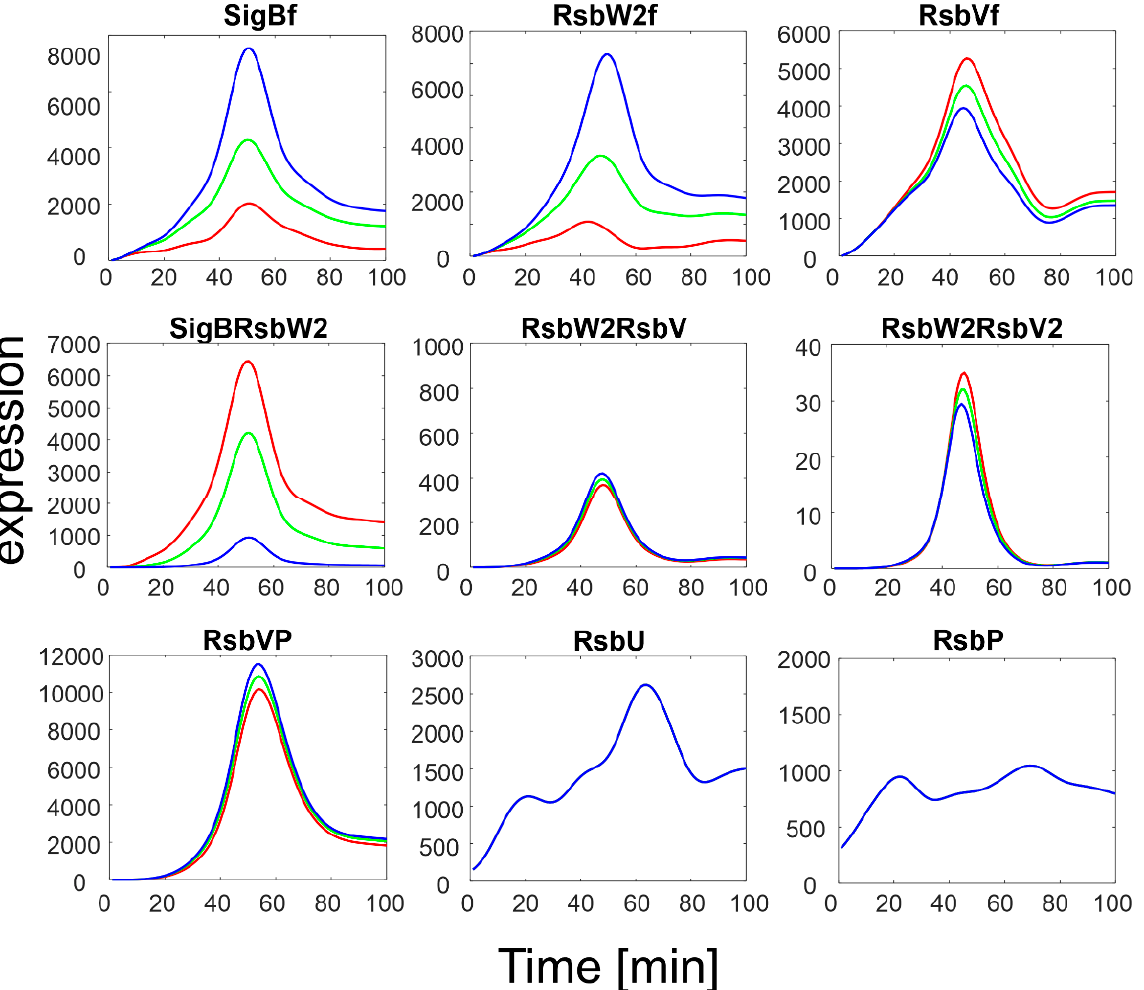
Figure 5. Simulation of the influence of the k 5 − /k 5+ ratio on the binding of anti-sigma factor to SigB. Red- k 5 − /k 5+ = 100, green, k 5 − /k 5+ = 2.5.10 3 , blue k 5 − /k 5+ = 5.10 4 . The original ratio was 5.10 3 . Index f-free form of the factor.